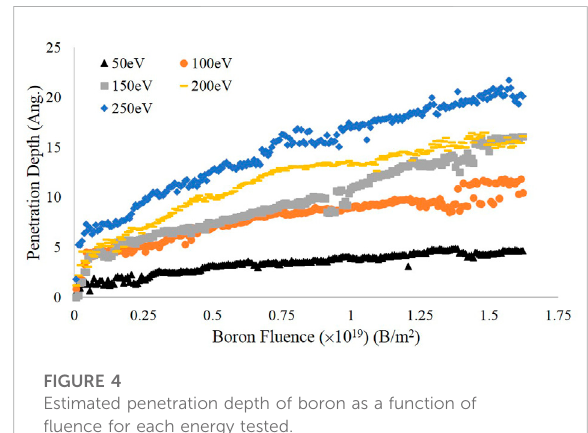
FIGURE 3 Shannon entropy as a function of fl uence for each energy